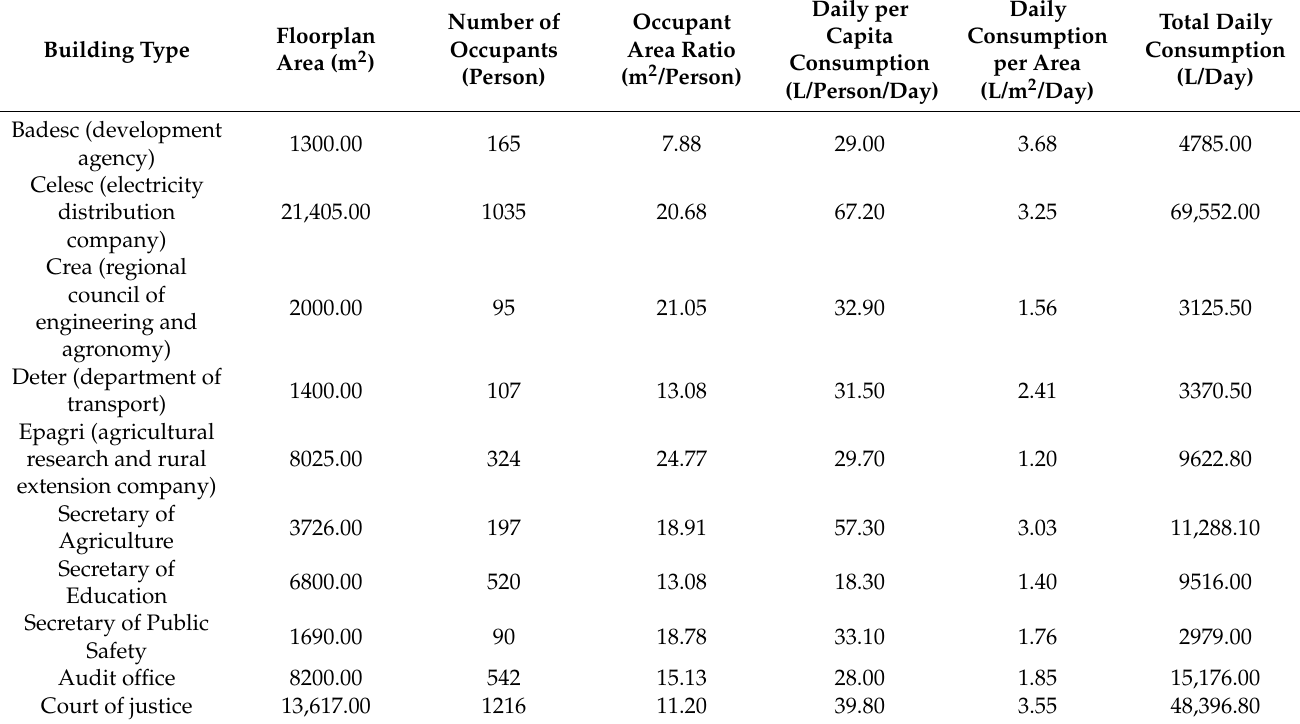
Table 4. Water consumption profiles in public buildings in Brazil. Based on Kammers and Ghisi